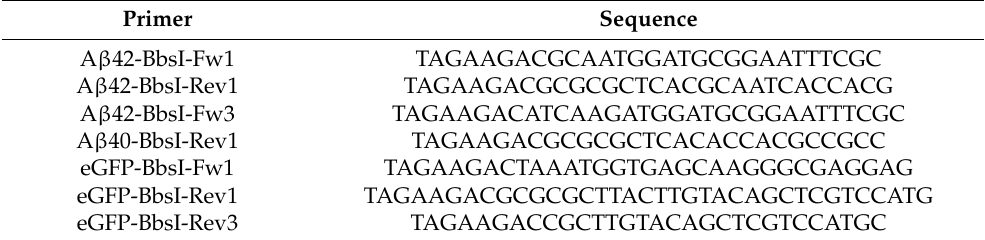
Table 2. List of